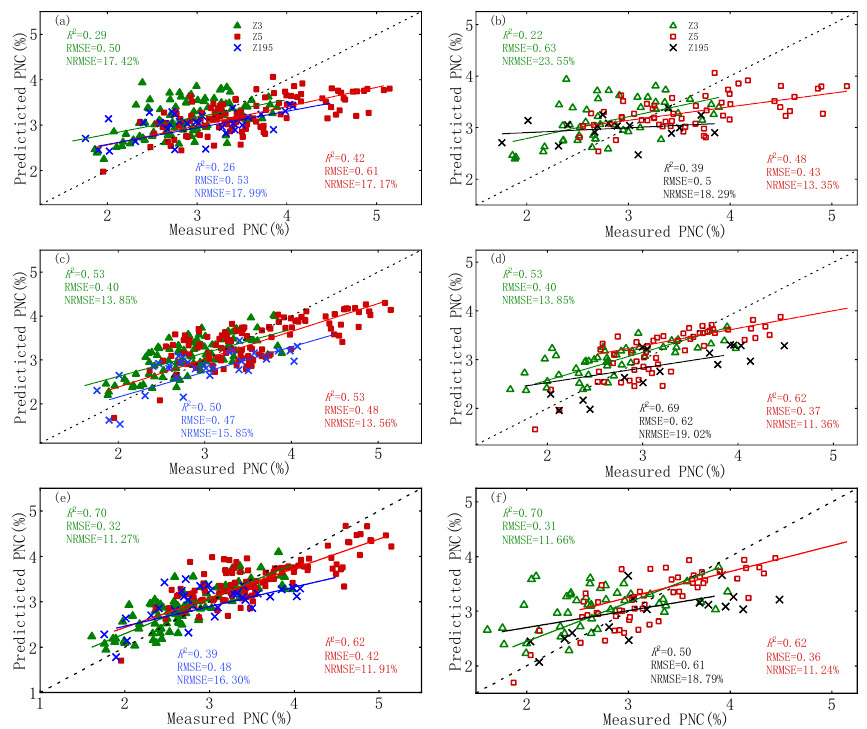
Figure 7. Predicted versus measured PNC. Predicted PNC was estimated by models constructed from the three optimal spectral indices to estimate the effect of potato PNC in different cultivars. ( a , c , e ) modeling dataset; ( b , d , f ) validation dataset.